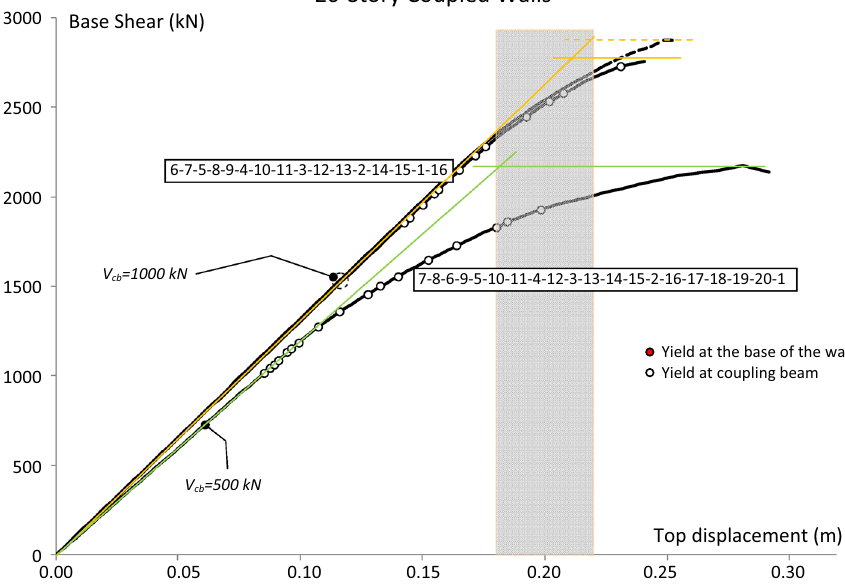
Fig. 8 Capacity curves for the set of 20-story coupled walls.